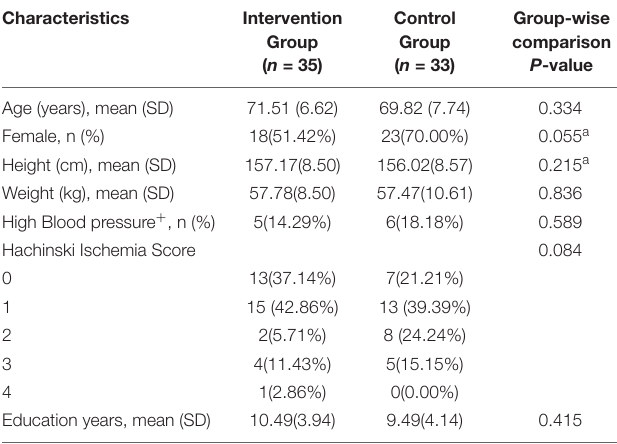
TABLE 1 | Patient characteristics at baseline.